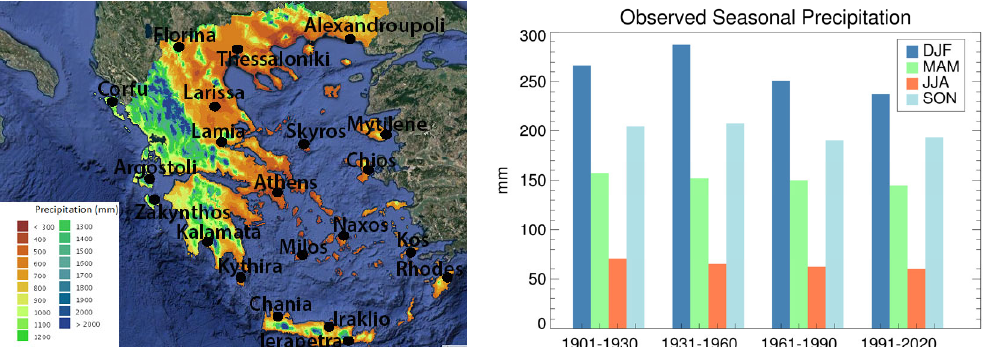
Figure 2. The map on the left shows the spatial distribution of mean annual precipitation throughout the study region of Greece. Blue/green (orange/red) colors represent wet (dry) subregions (source: http://climatlas.hnms.gr accessed on 25 January 2023). The locations of the stations used are marked. The diagram on the right presents the observed seasonal precipitation in different 30-year periods (data source: World Bank Group, Climate Change Knowledge Portal).